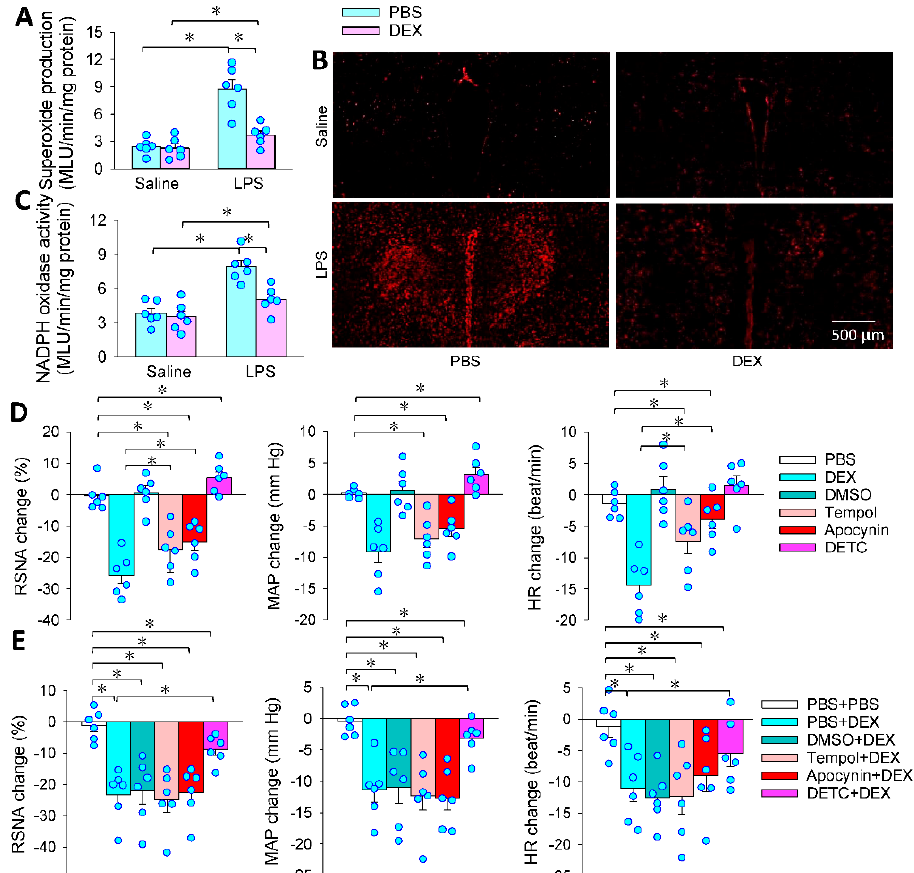
Figure 4. ROS mediates the effects of DEX in LPS-treated rats. PVN microinjection was carried out 24 h after the intraperitoneal injection of LPS. ( A ) Superoxide production in the PVN in saline- and